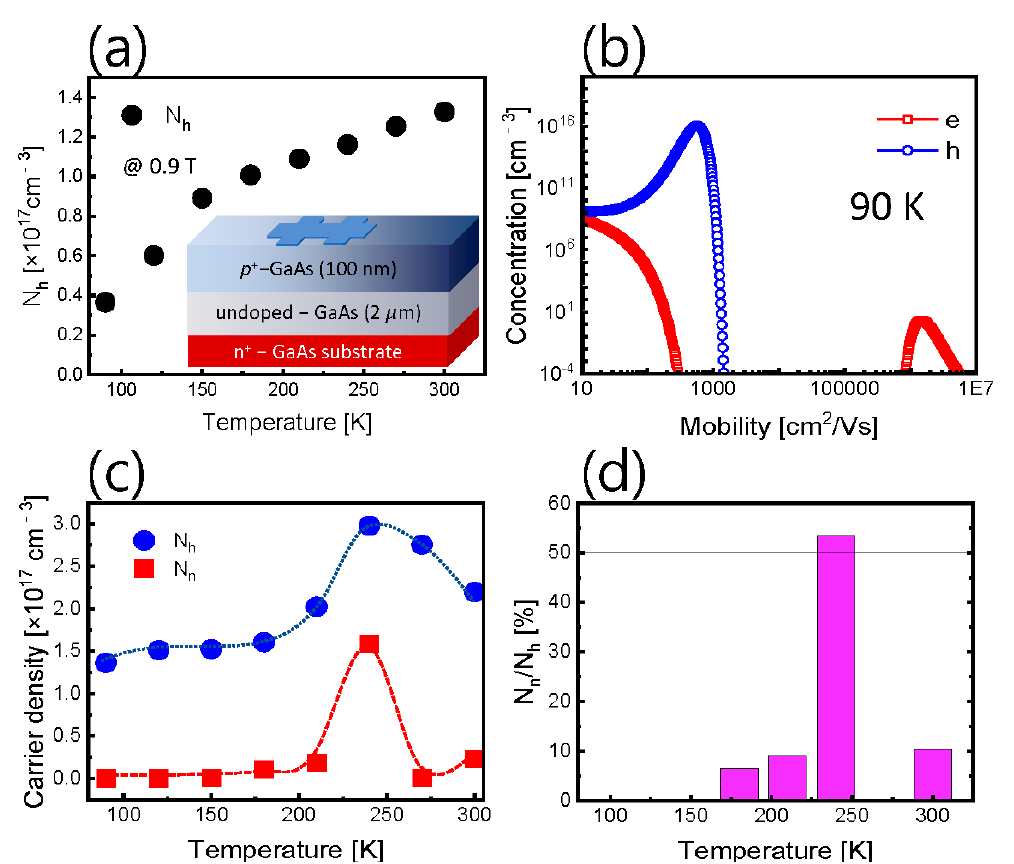
Figure 1. ( a ) Conventional Hall measurement data at 0.9 T. ( b ) Carrier density of the electron and holes at 90 K. ( c ) Temperature-dependent electron and hole density from ME-MSA. ( d ) The ratio of the electron and hole densities from Figure 1c. Note that the temperature position of the maximum ratio above approximately 50% is comparable with the temperature of the DLTS signal found (see Figure 2b,c).